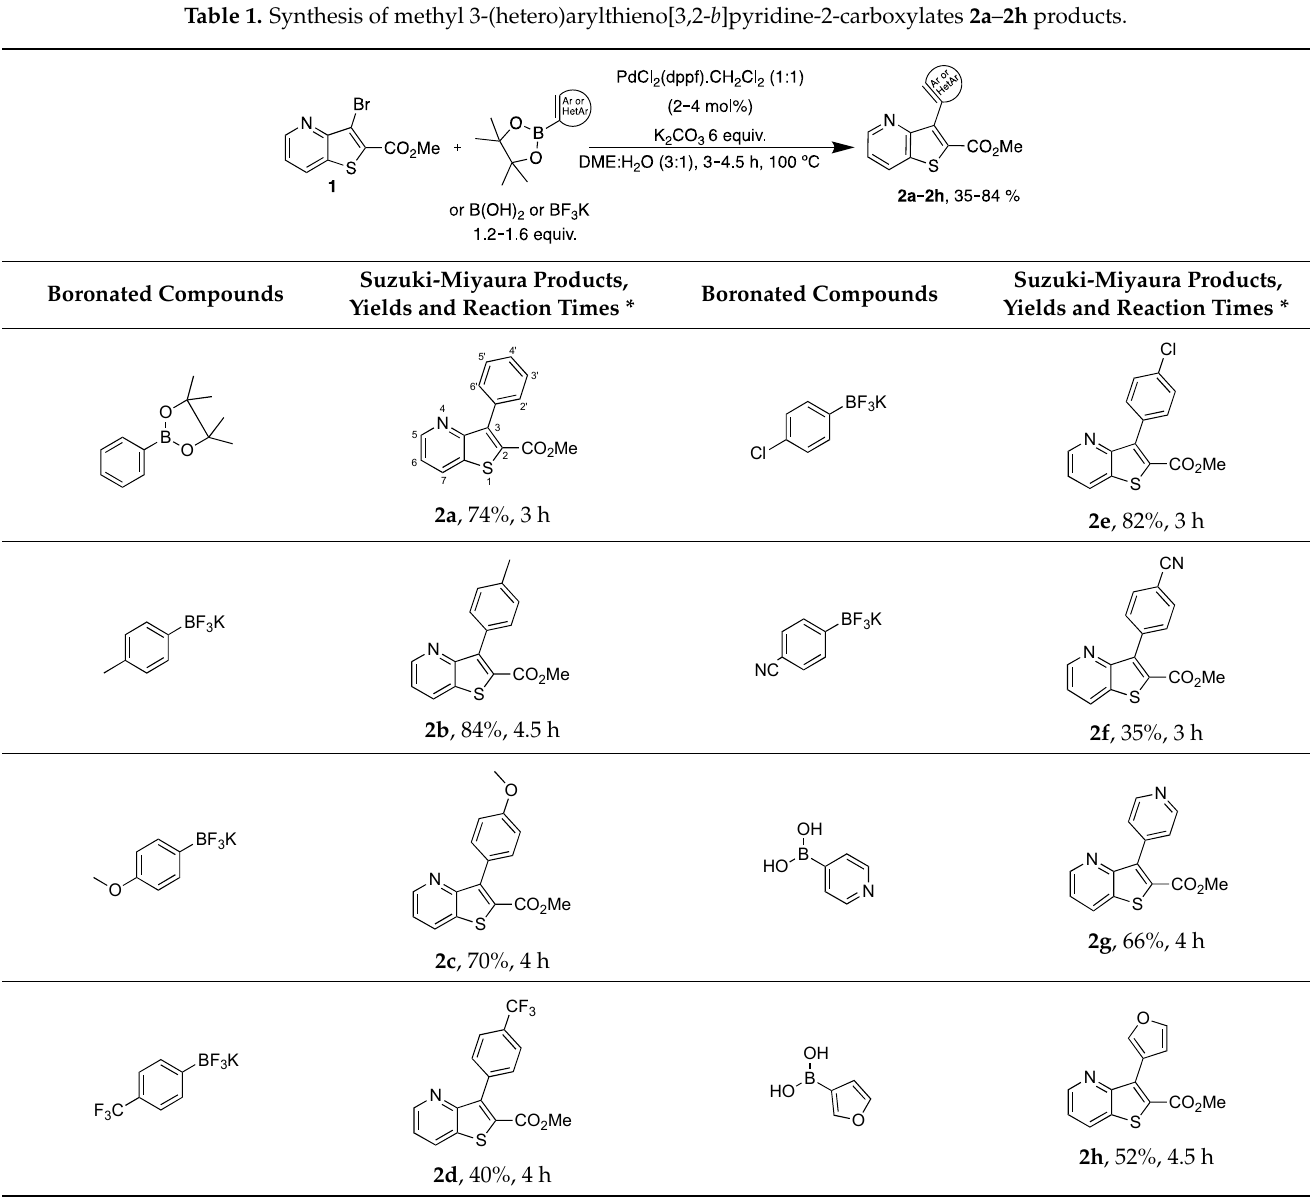
Table 1. Synthesis of methyl 3-(hetero)arylthieno[3,2- b ]pyridine-2-carboxylates 2a – 2h products.